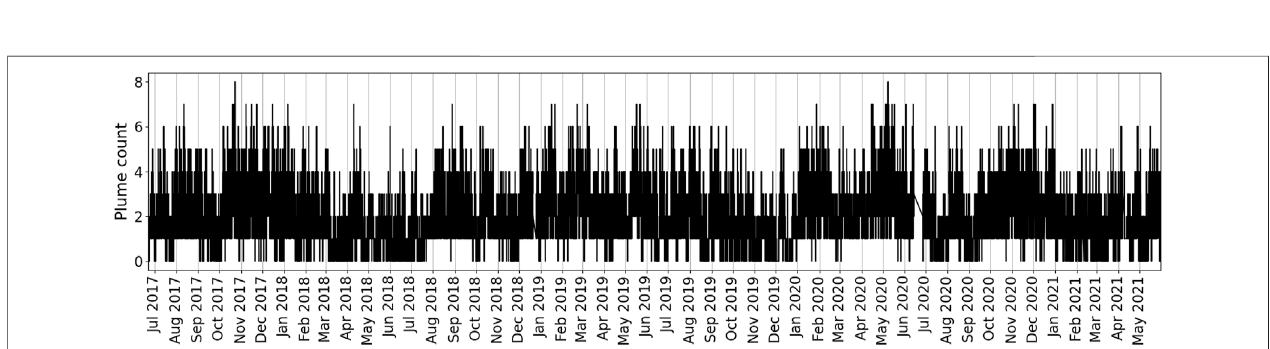
FIGURE 11 | Number of detected fl ares throughout the monitoring period (between 22 June 2017 and 30 May 2021).